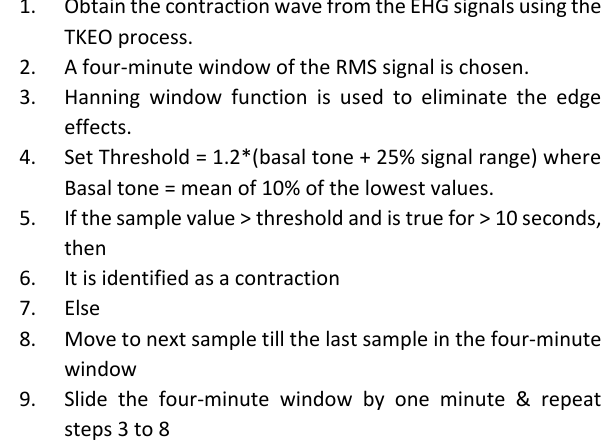
Fig.1: Representation of surface electrode positioning on the abdominal